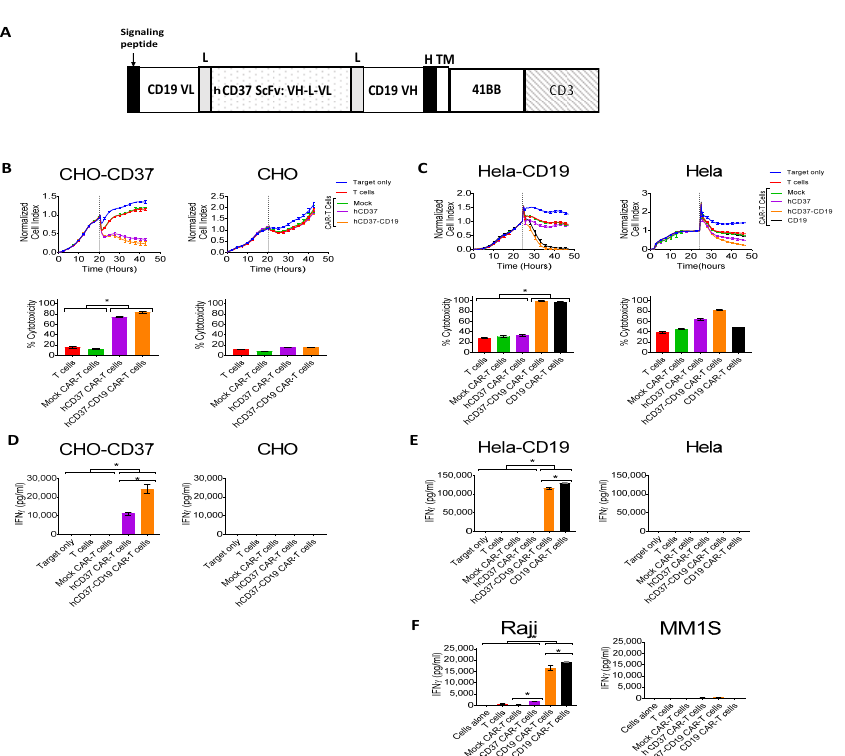
Figure 4. Bi-specific hCD37-CD19-CAR-T cells specifically target CD37-positive and CD19-positive cells. ( A ). The structure of bi-specific CD37-CD19 CAR-T cells. VL-light chain; VH-heavy chain; ScFv-single chain variable fragment; L-linker; H- hinge; TM, transmembrane domain. ( B ). RTCA activity of hCD37-CD19-CAR-T cells with CHO-CD37 cells (left) and CHO cells (right). Cytotoxicity of bispecific CD37-CD19 CAR-T cells against CHO-CD37 cells was significantly higher than that of humanized CD37 CAR-T cells, *, p < 0.0001, hCD37 and hCD37-CD19-CAR-T cells with CHO-CD37 cells vs T and Mock CAR-T cells, One-Way ANOVA followed by Sidak’s multiple comparison test p = 0.0006. ( C ). RTCA activity of hCD37-